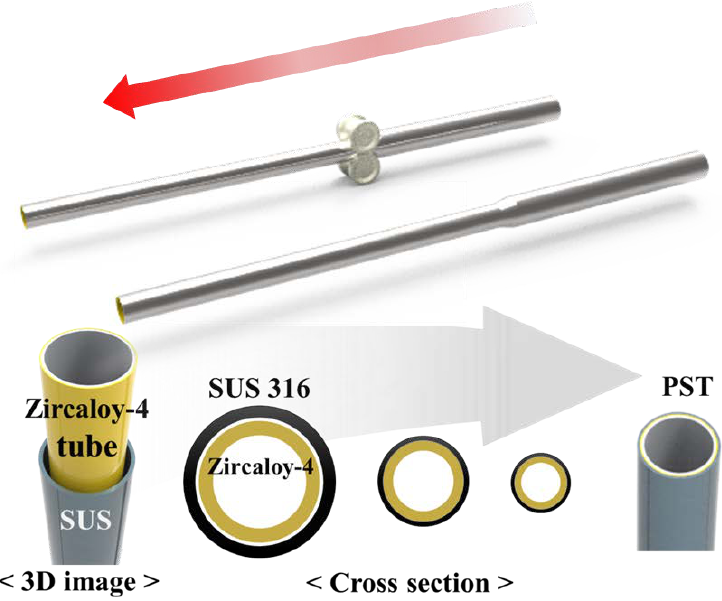
Figure 1. Schematic view of the swaging method for a double tube and the stress type applied to the tube during the process.